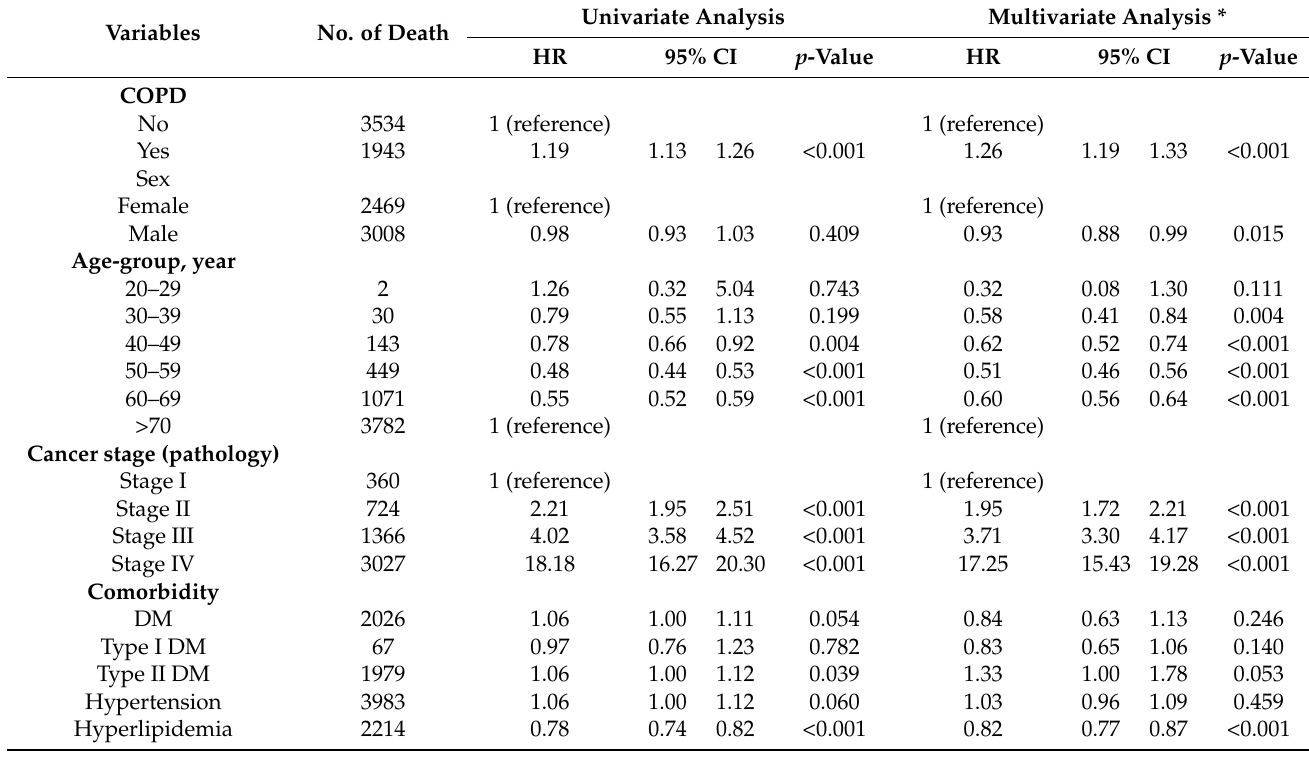
Figure 3. Subgroup analysis of cancer-related mortality with Cox regression model adjusted for sex and age-group by cancer stage, without propensity score matching. Total 31,896 patients with colorectal cancer were followed up for 5 years. The forest plot displays adjusted hazard ratios (HRs) and 95% confidence intervals (CIs) between preexisting chronic obstructive pulmonary disease (COPD) patients and non-COPD groups with different cancer stages by multivariate anal- ysis.